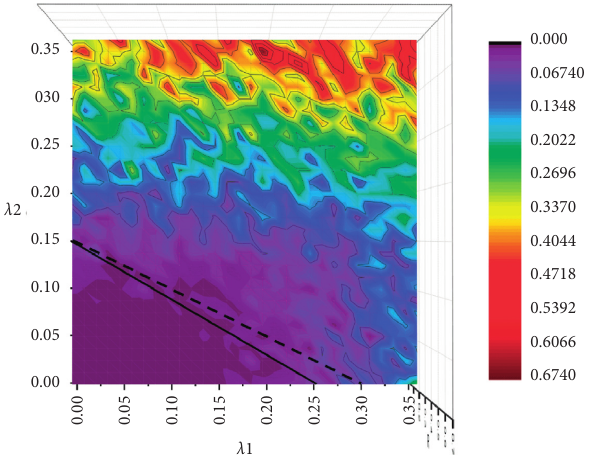
Figure 12: The vertical view of Figure